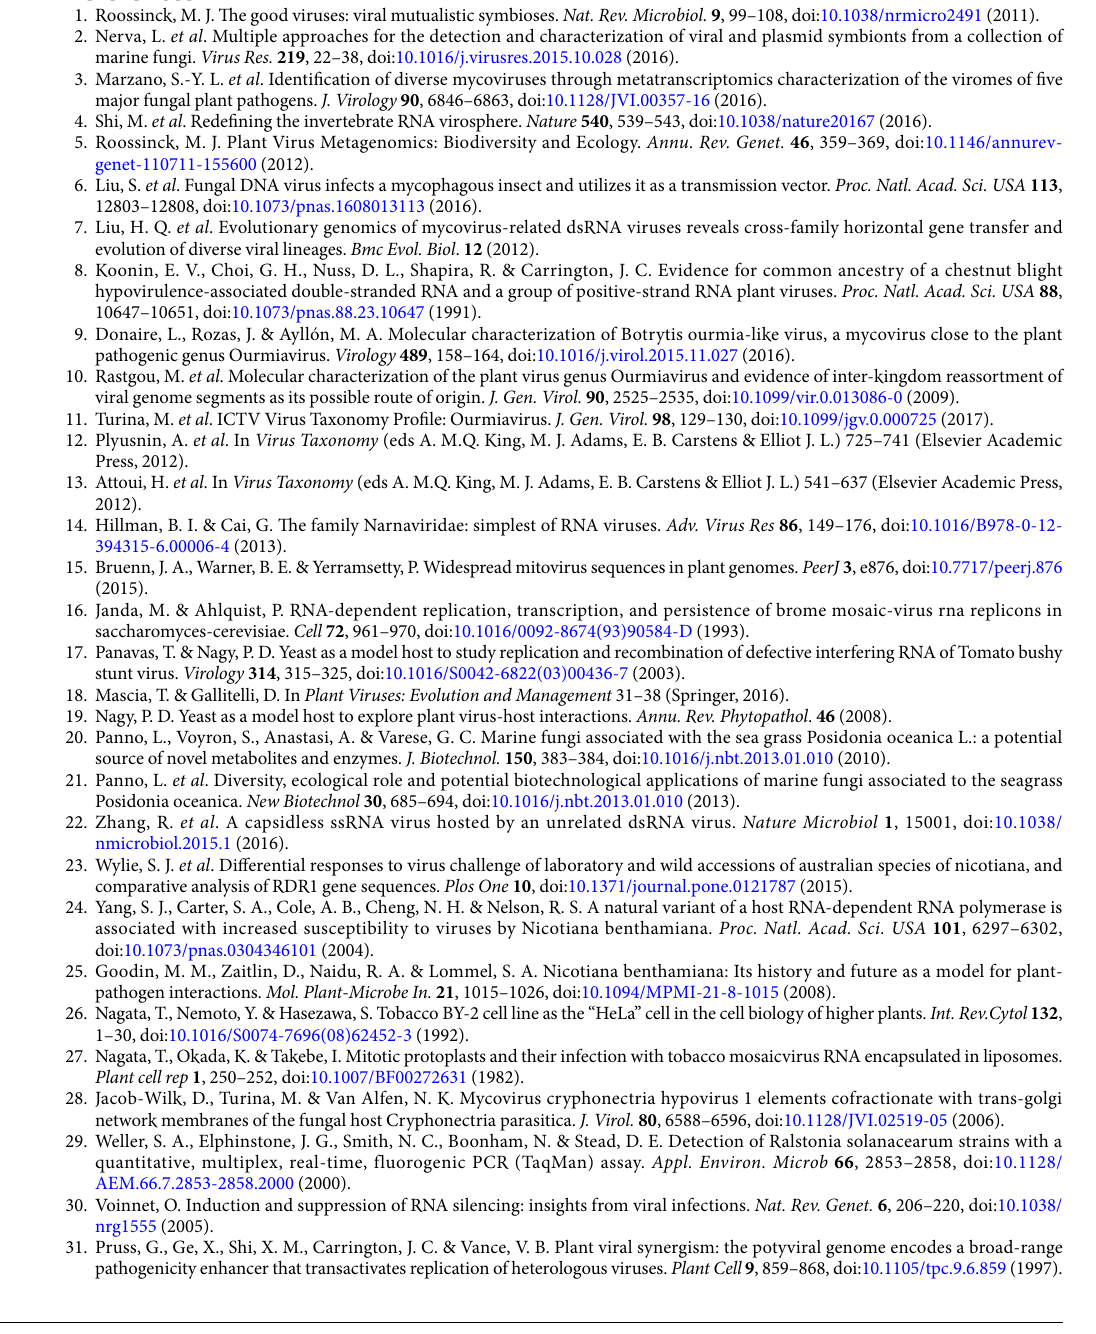
nucleotide position derives from at least 3 distinct clones. Statistical analysis. Threshold detection levels were calculated automatically by the Bio-Rad CFX